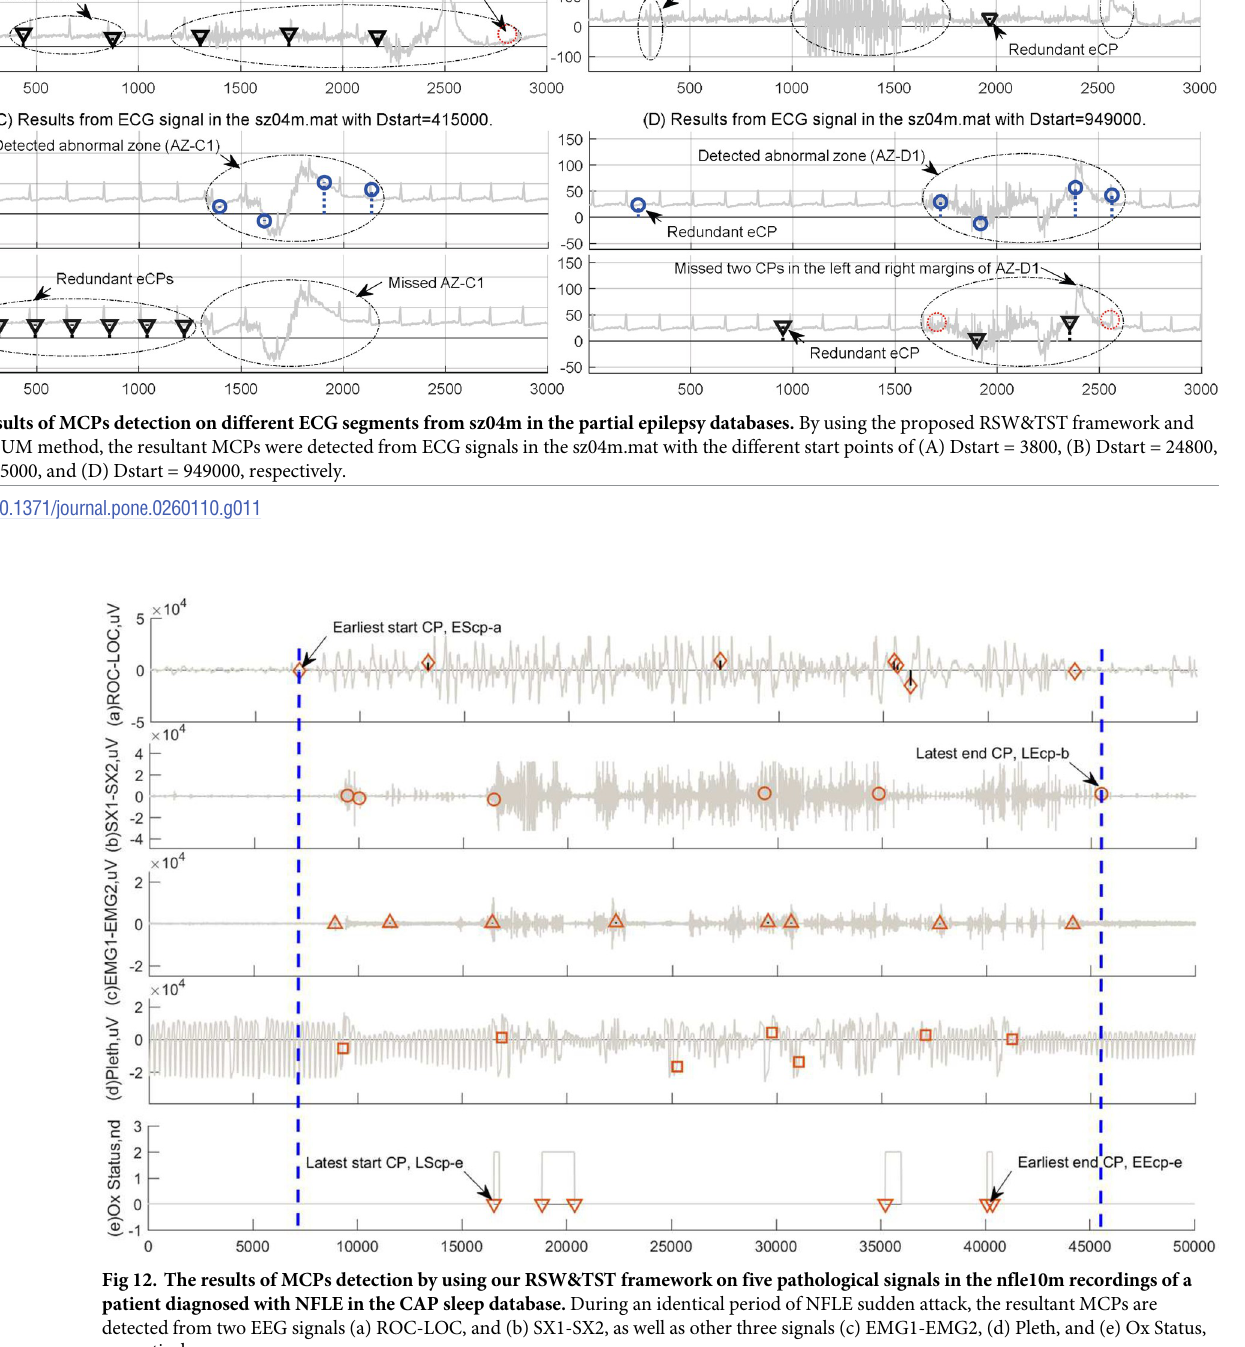
PLOS ONE | https://doi.org/10.1371/journal.pone.0260110 December22,